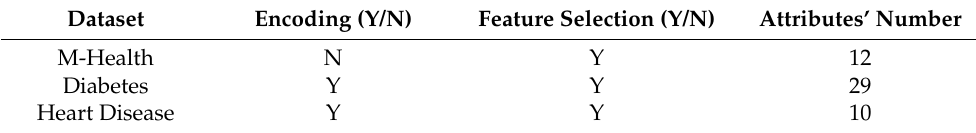
Table 3. Characteristics of the three datasets after preprocessing and feature selection.